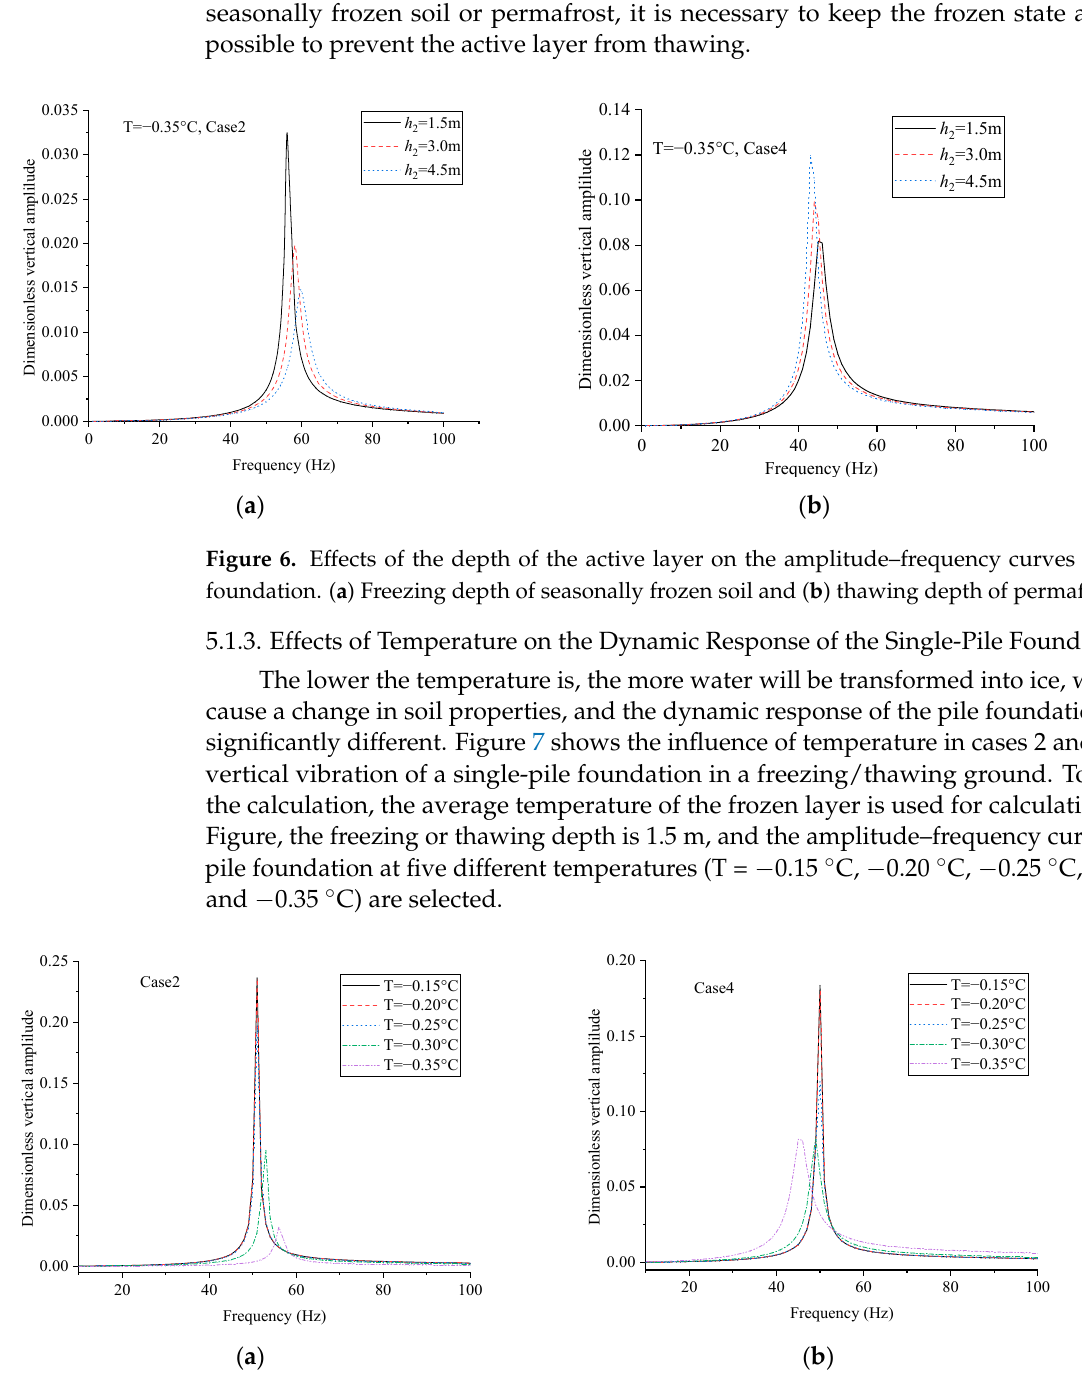
Figure 7. Effect of temperature on the amplitude–frequency curves of the single-pile foundation in ( a ) Case 2; ( b ) Case